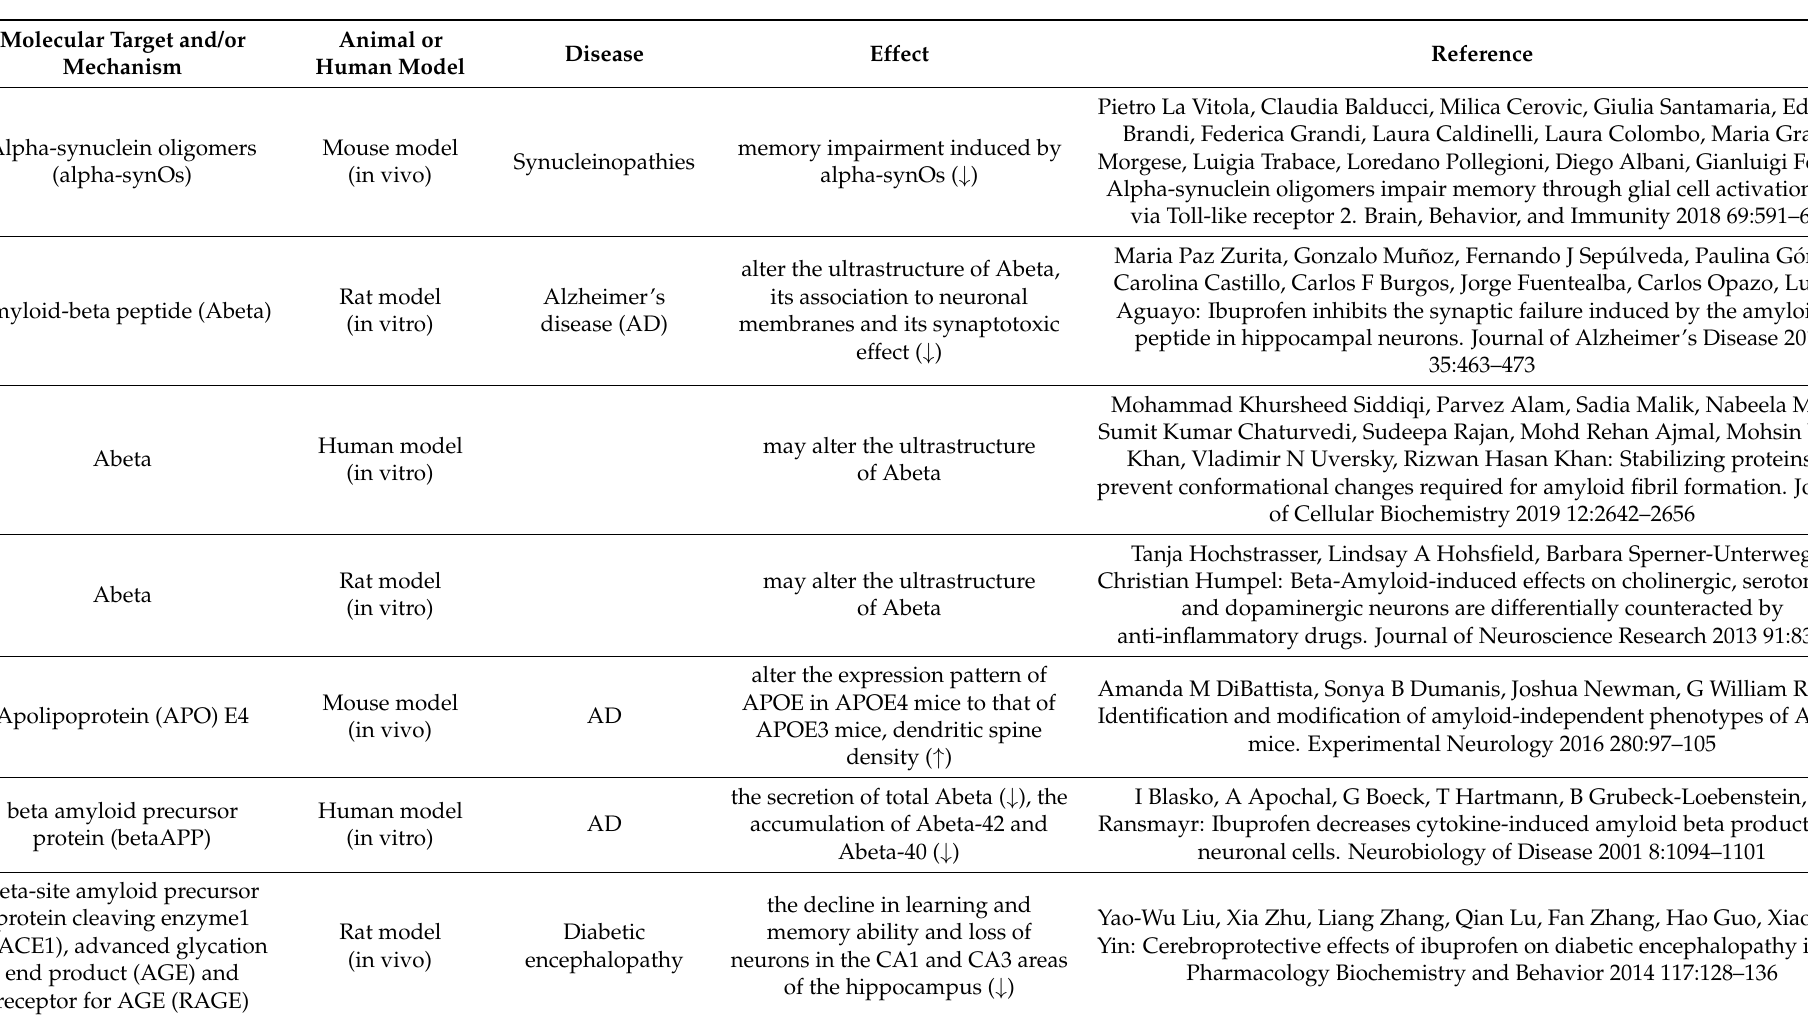
Table 2. Molecular targets of ibuprofen and its effects on cells and tissues. Up arrow indicates upregulation or increase whereas down arrow shows downregulation or